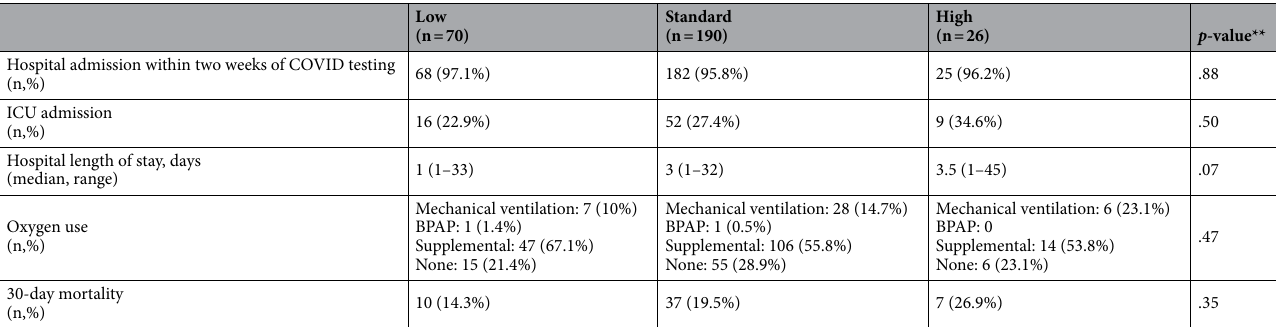
Table 5. Active PPI use: outcomes based on PPI dosage (n = 286)*. * PPI Proton pump inhibitor. **Based on separate chi square or Kruskal Wallis tests, as appropriate.